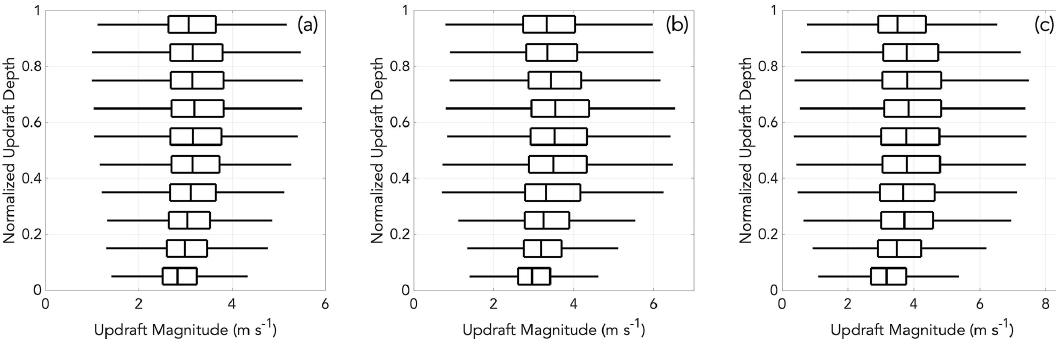
Figure 5. For all 13 COMBLE cases, box-and-whisker plots of updraft magnitude as a function of normalized updraft depth for (a) updrafts with a depth less than 1km, (b) updrafts with a depth between 1 and 2km, and (c) updrafts with a depth greater than 2km.